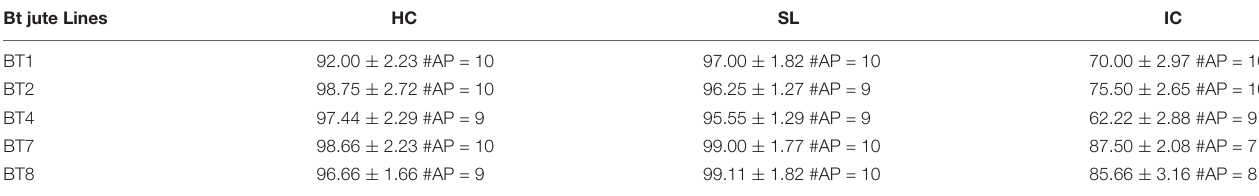
TABLE 3 | Transgenic Bt jute lines and their mortality (%) in WPB.